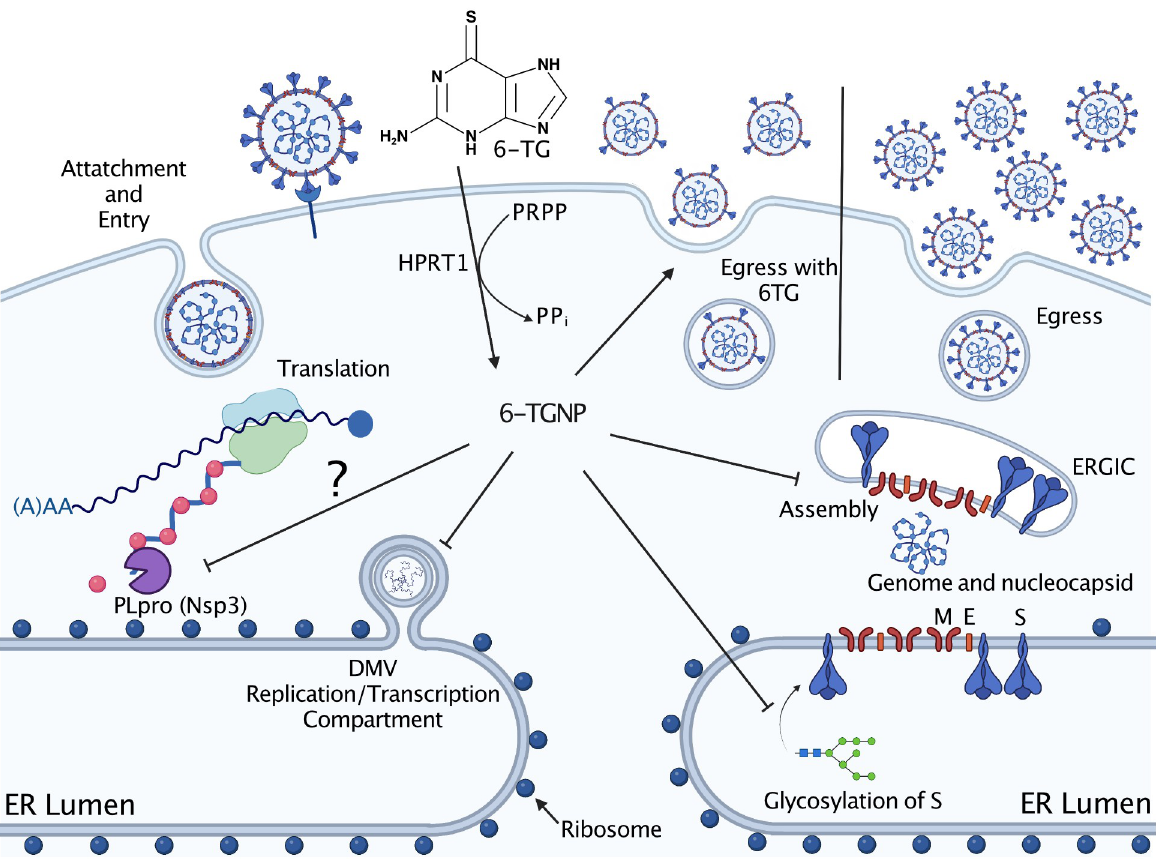
Fig 8. 6-TG inhibits multiple essential steps in virus replication and assembly. 6-Thioguanine (6-TG) is converted into 6-thioguanosine monophosphate (6-TGMP) by HPRT1, which can be subsequently processed into diphosphate (6-TGDP) and triphosphate forms (6-TGTP) (collectively known as 6-TGNP). HPRT1-dependent conversion of 6-TG to a nucleotide form is required for antiviral activity, which comprises defects in accumulation of viral RNAs and proteins, as well as defects in Spike glycosylation and incorporation into viral particles. The model presented in Fig 8 was adapted from “Coronavirus Replication Cycle”, by BioRender.com (2022). Retrieved from https://app.biorender.com/ biorender-templates.